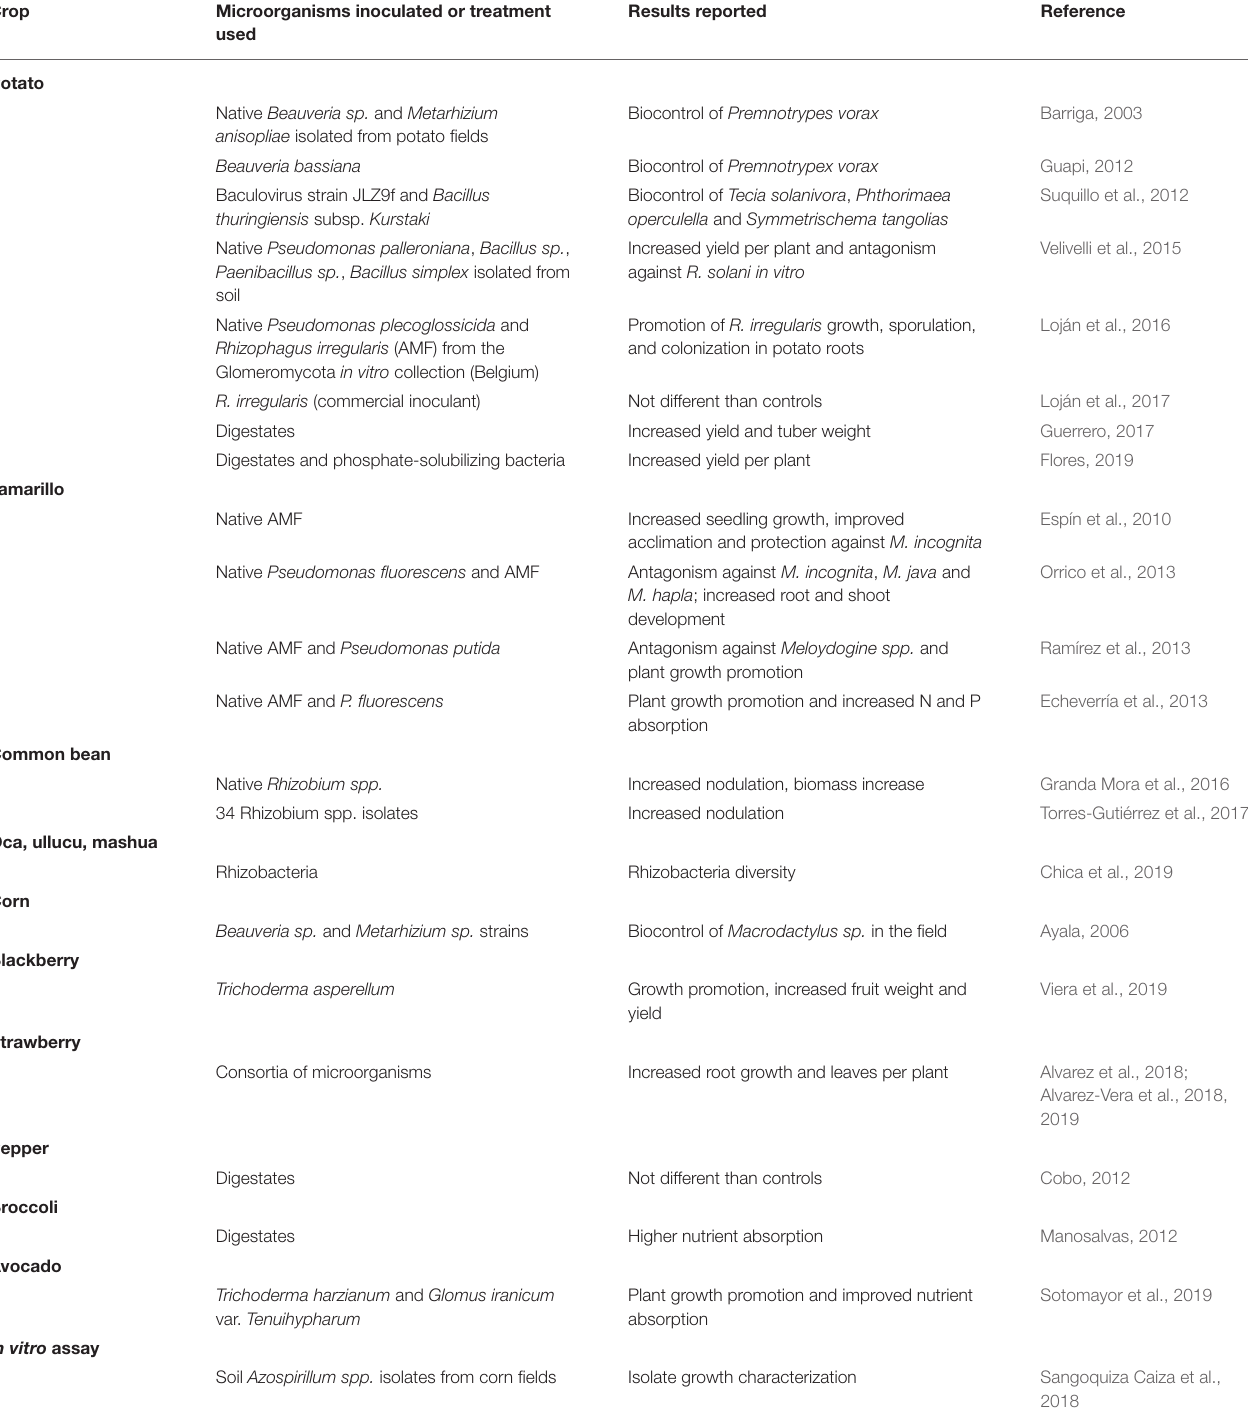
TABLE 1 | Studies reporting results of the prospection and evaluation of microbial technologies in the Ecuadorian Andes.